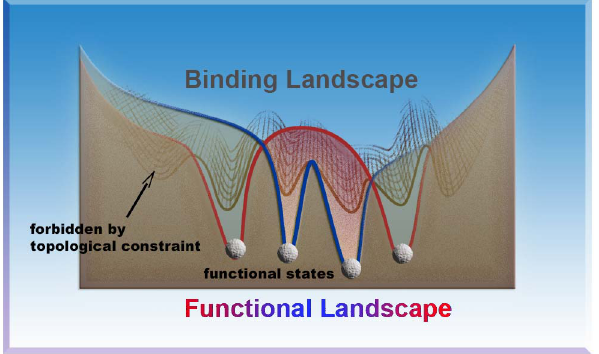
Figure 8. Schematic picture that the functional landscapes of different diUb chains are selected from the same binding landscape of two Ub monomers by corresponding topological constraint. The binding landscape (grey) is a description of binding between two free Ub monomers, while the functional landscapes are a description of binding between two Ub units with an additional topological constraint, e.g. a peptide bond formed between proximal Ub and distal Ub. Two typical different topological constraints are represented by red and blue, respectively. Our simulation results reveal that the binding landscape contains most of functional states of diUbs with different linkage types. And part of these functional states are further stabilized by the corresponding linkages. Such as, the functional landscape of K48-diUb has a deeper basin of the I44-I44 conformational state which is also present on the binding landscape. But other functional states, such as compact conformation of K11-diUb and K63- diUb, cannot be sampled on the functional landscape of K48-diUb. In other words, these conformational space is forbidden as a consequence of specific topological constraints (grey and dark regions). The topological constraint limits the conformational space and selects the local interactions for realizing the corresponding biological function. Therefore, the topological constraint provides a way for breaking the binding symmetry and reaching the functional